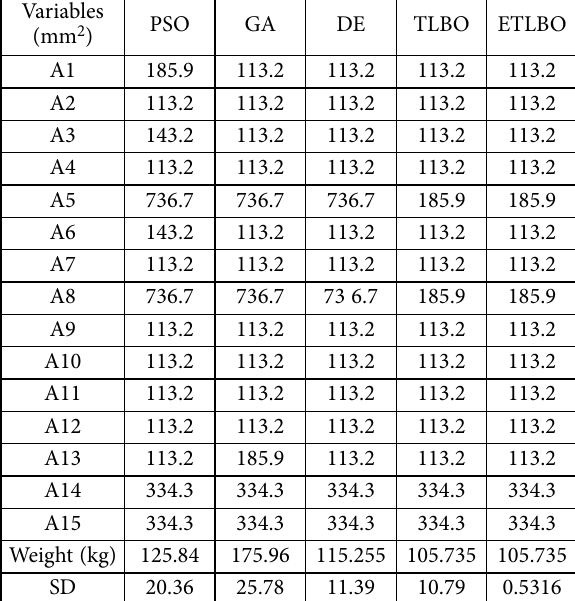
Figure 5. 15-bar truss